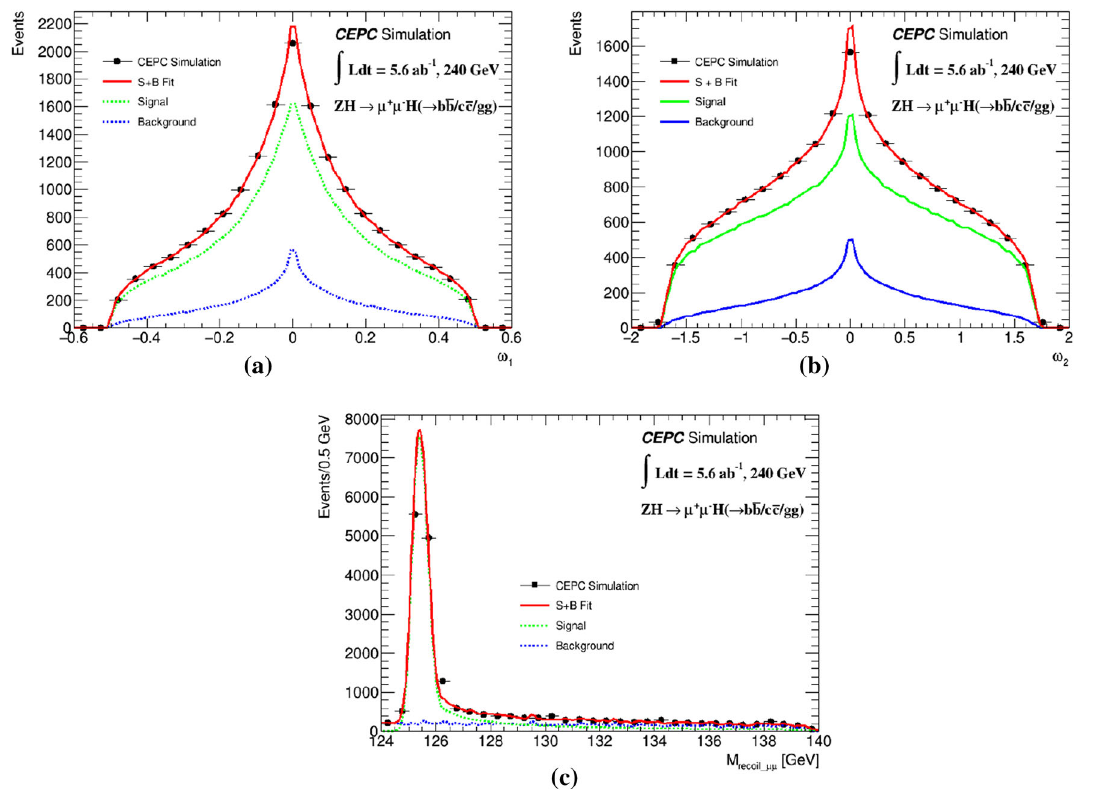
Fig. 3 a Fitresult projectedon ω 1 distribution in μ + μ − H channel, b fit result projectedon ω 2 distribution in μ + μ − H channel, c fit resultprojected on recoil mass distribution in μ + μ − H channel